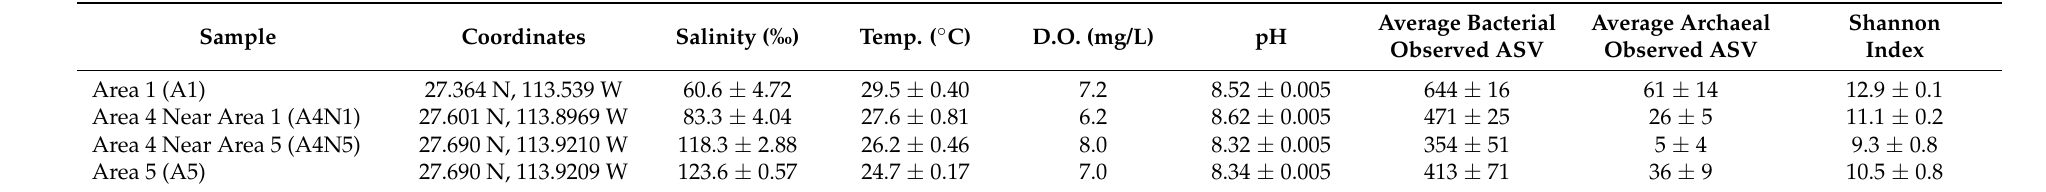
Table 1. Sampling sites, physicochemical parameters at Exportadora de Sal, S.A., Guerrero Negro, BCS, M é xico and calculated alpha diversity from 16S rRNA archaeal sequences. Values corresponding to the arithmetic mean of triplicate measurements of the interstitial water from microbial mat samples. Dissolved oxygen (D.O.) was measured in the laboratory without replicates. Abbreviation codes for each sample are bracketed in